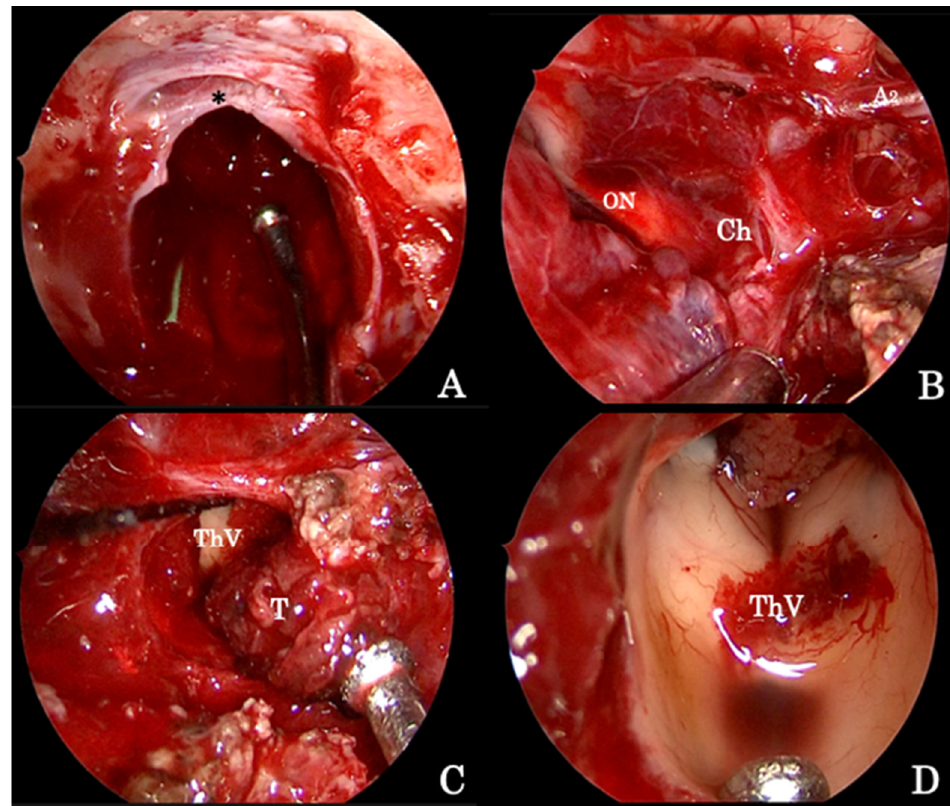
Figure 2. Intraoperative image detailing the endoscopic endonasal procedure for the removal of a giant pituitary adenoma. ( A ) The osteodural breach is created both at the level of the sella and of the sphenoid planum between the protuberances of the optic nerves; the sellar infradiaphragmatic component of the adenoma is removed first. ( B ) Thereafter, the supradiaphragmatic area is exposed and tumor removal is completed by means of standard microsurgical techniques taking care of the dissection lesion off the arachnoid under the close-up endoscopic view. ( C ) The tumor followed along its vertical growth pattern inside the third ventricle cavity, which, at the end, is explored ( D ). A2 segment of the left anterior cerebral artery (A2); optic nerve (ON); optic chiasm (Ch); third ventricle cavity (ThV); tumor (T); diaphragma sellae (*).